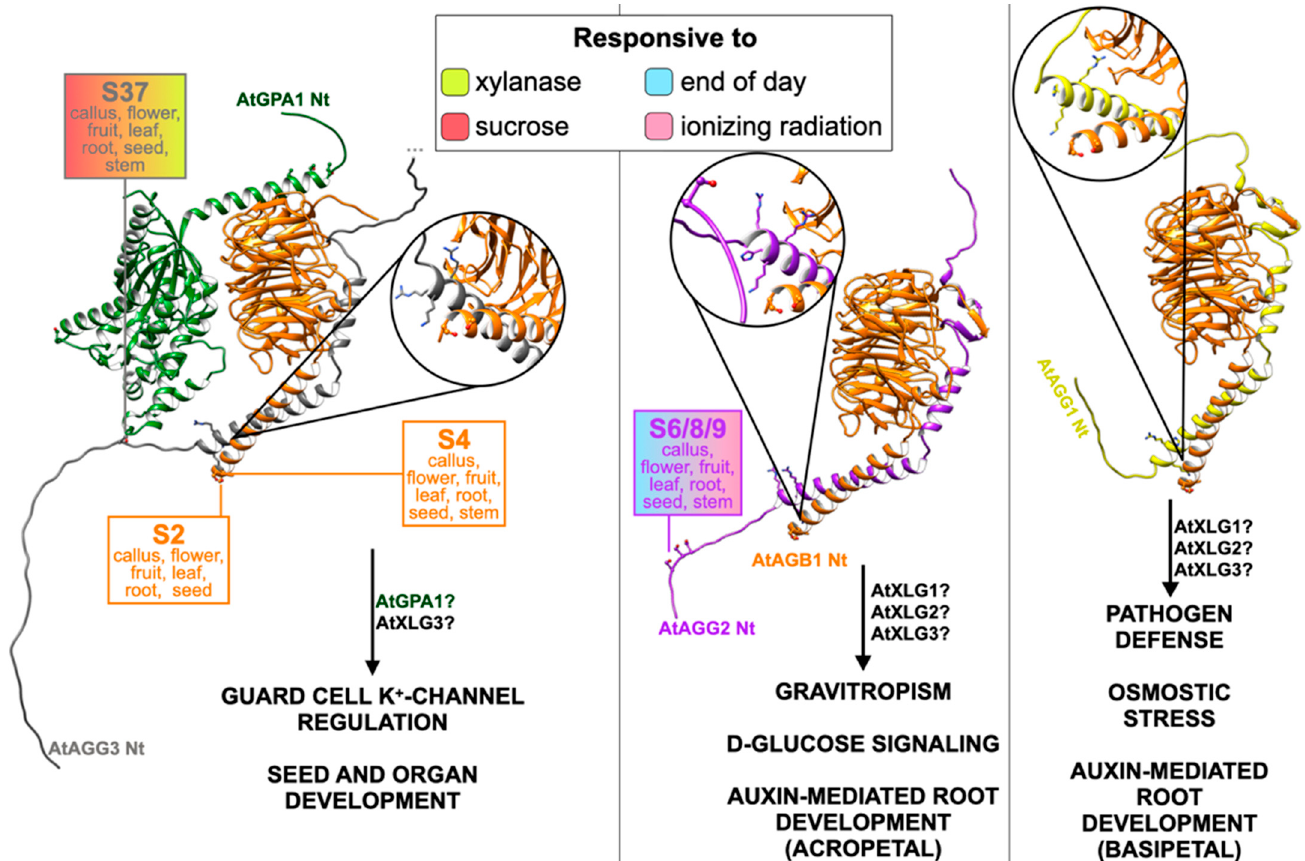
Figure 4. G βγ specificity and function distinction. AtGPA1 (forest green) binds preferentially to AGB1 (orange) when dimerized with AGG3 (grey), which regulates ion transport, seed, and organ development [72,87–89]. β -dimerized AGG2 (purple) binds to the XLGs in order to regulate gravitropism, sugar responses, and root development [72,86]. Phosphorylation occurs in vivo at the N-terminal portions of AGB1, AGG2, and AGG3 [26,42,60]. Beta-gamma complex models were created using AlphaFold2, and top-ranked models were selected for analysis [35]. The heterotrimeric complex was created by overlapping the models with the crystal structure of the heterotrimeric G-protein complex of Bos taurus (PDB 1GOT). Experimental data were obtained from the PhosphAt database (https://phosphat.uni-hohenheim.de, accessed on 23 May 2022) and ATHENA (http://athena.proteomics.wzw.tum.de, accessed on 23 May 2022). AGG3 unmodeled C-terminal regions were removed for better visualization. ATHENA was used to identify tissue-specific phosphorylation, which is pointed out below residue identification. Phosphosites are represented as balls and sticks. Candidate AGB1pS37-interacting residues are represented as sticks only. Color filling indicates experimental treatments.